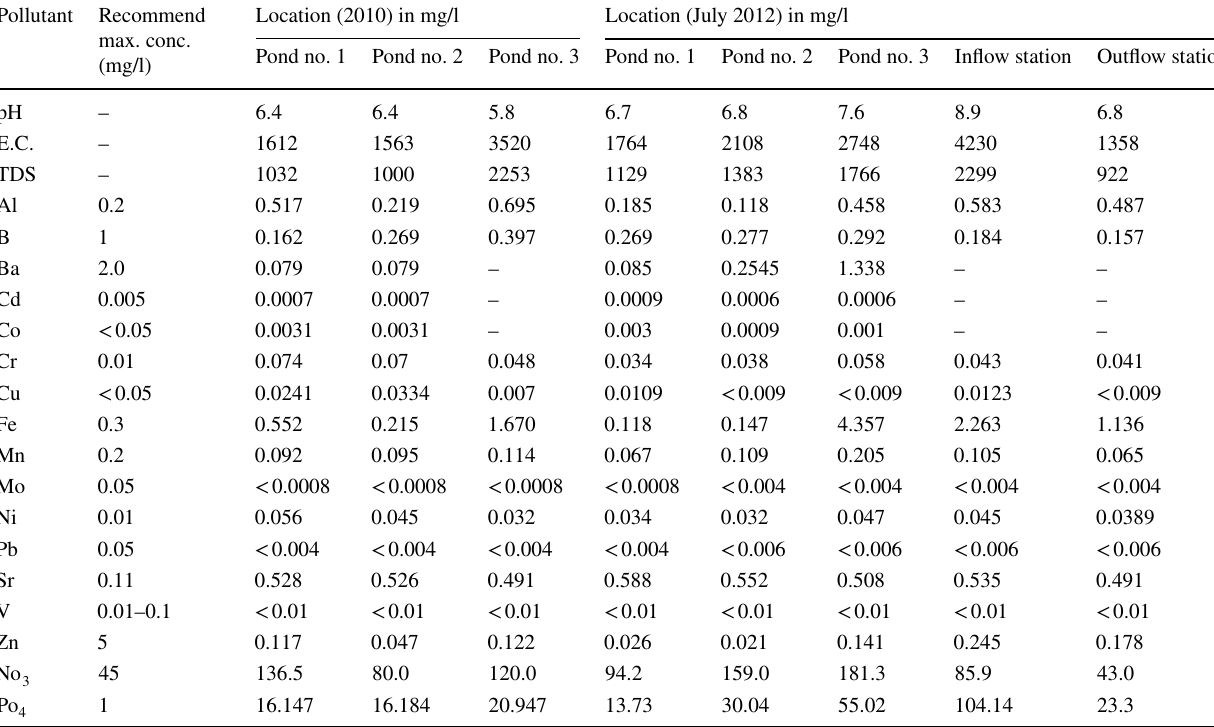
Table 2 Chemical inorganic and biological analysis of wastewater samples in the 10th of Ramadan city expressed in mg/l (2010, 2012) Pollutant Recommend max.